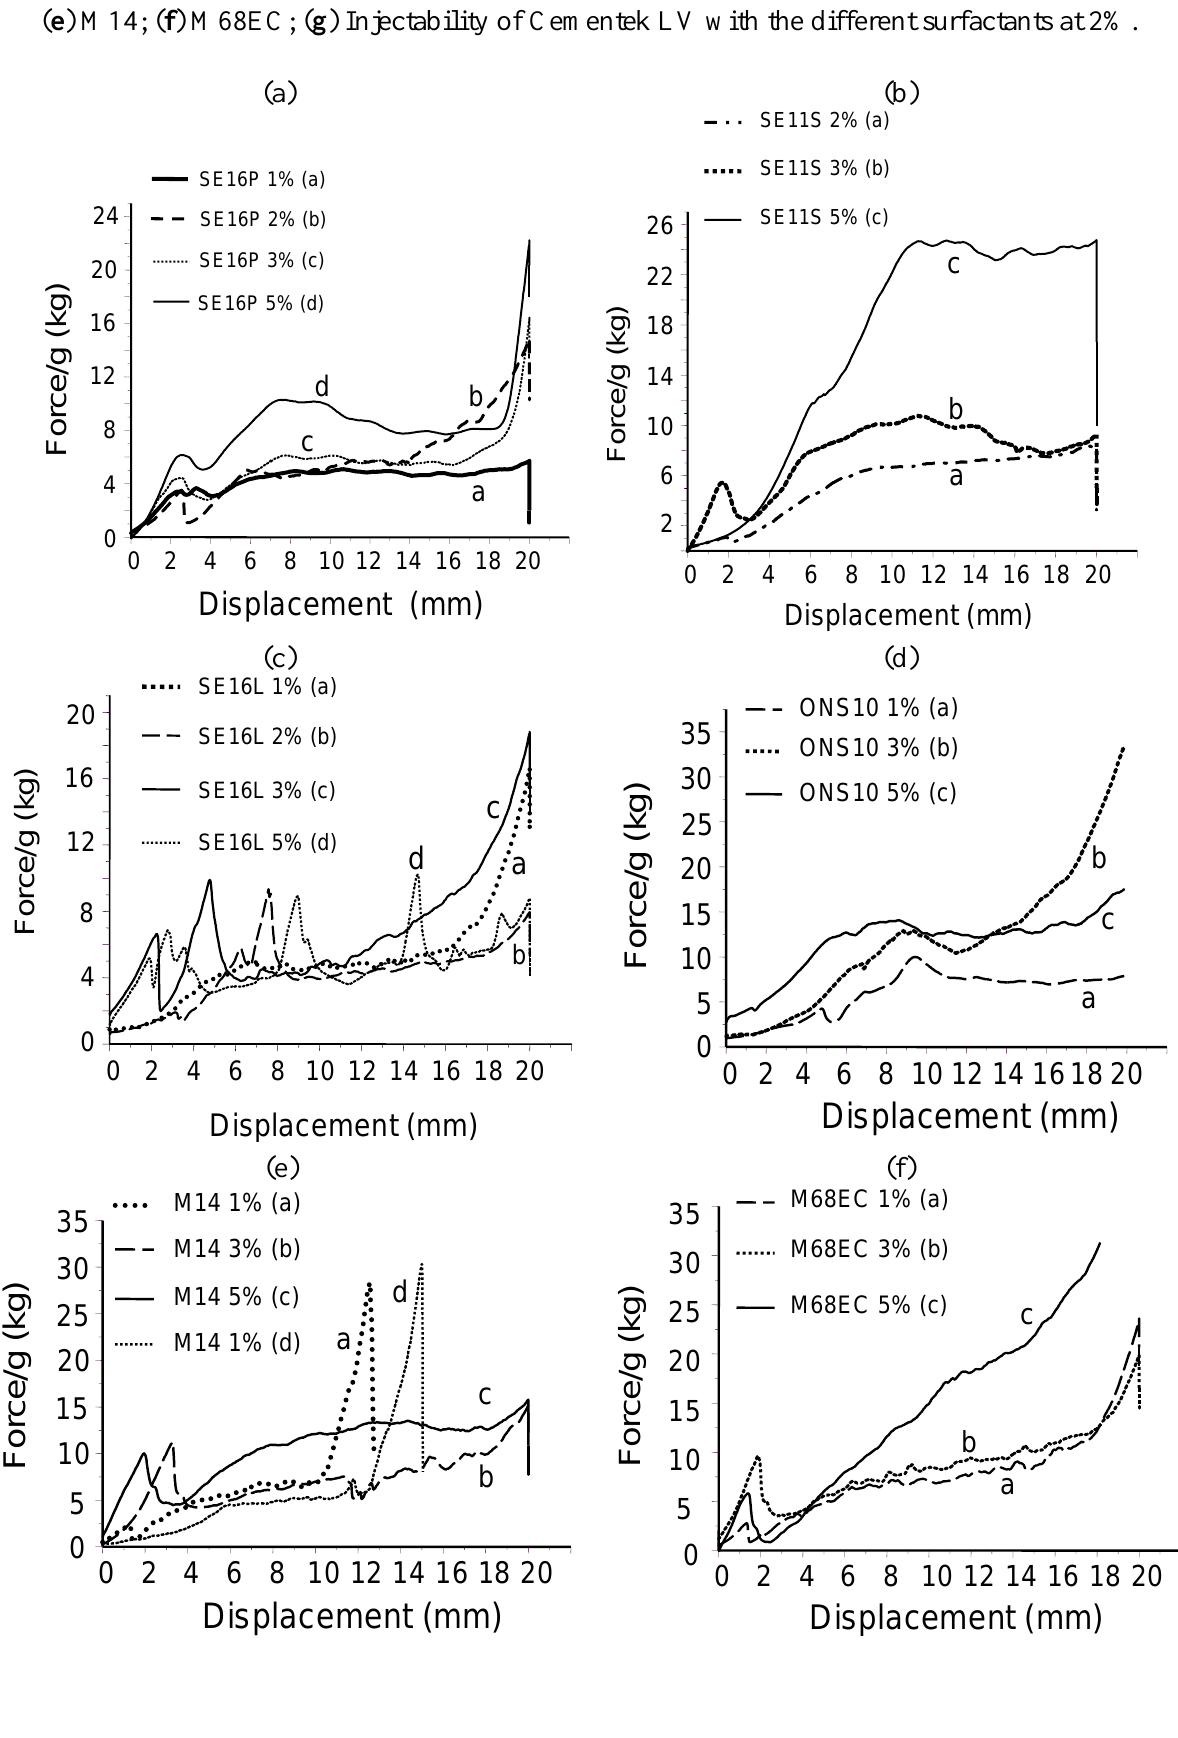
Figure 1. Injectability of Cementek with: ( a ) SE16P ; ( b ) SE11S; ( c ) SE16L; ( d )